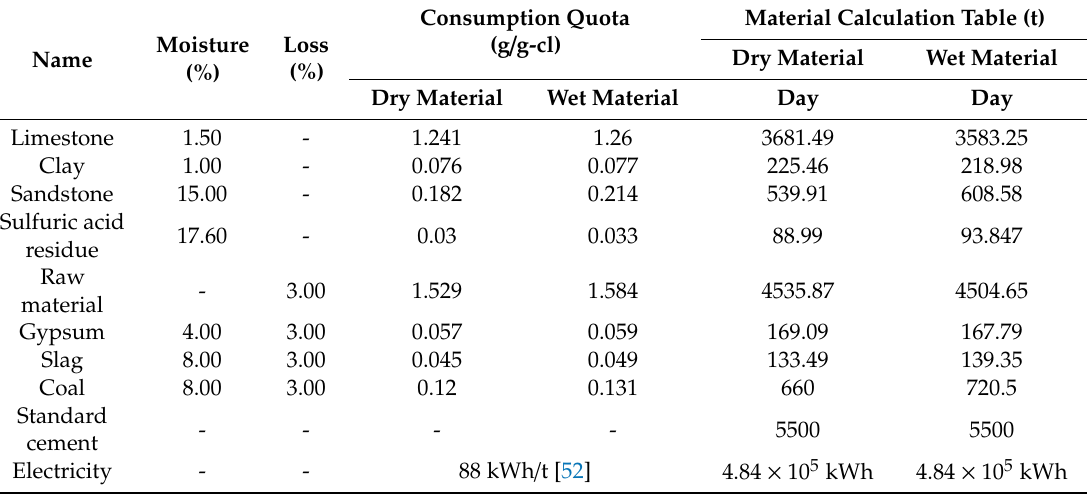
Table 16. Consumption quota calculation table of the raw materials (5000 t /